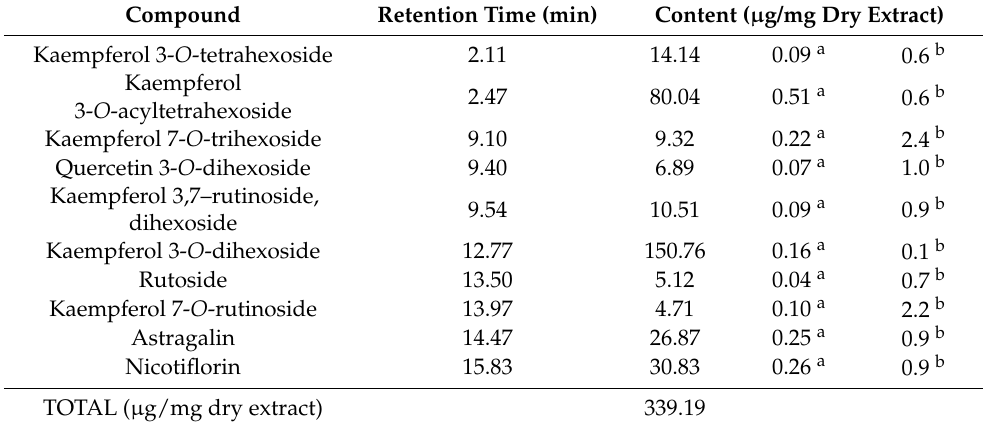
Table 2. Flavonoid content in CA extract.